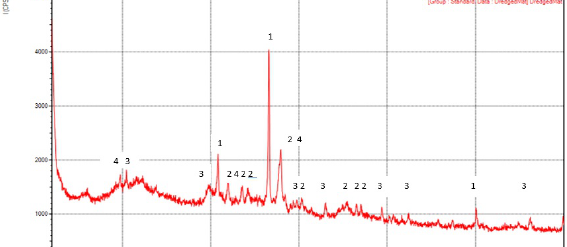
Table 2. XRF analysis of the dredged